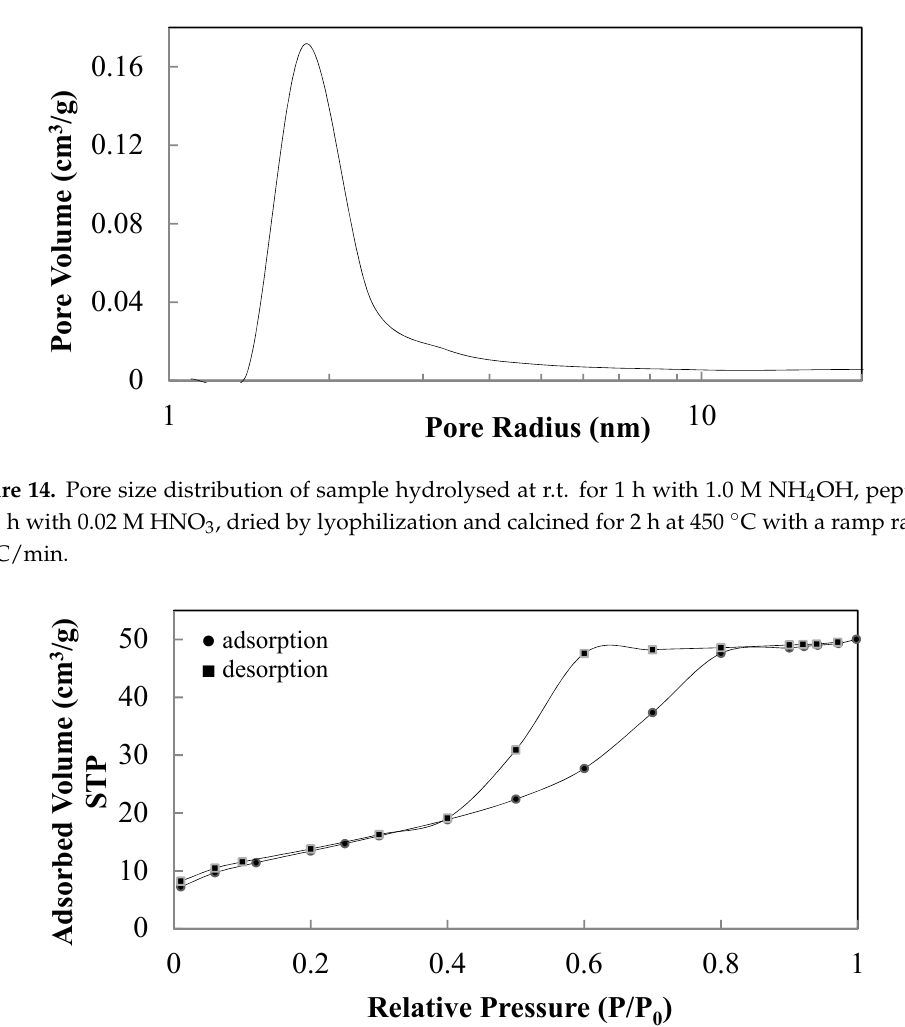
Figure 15. N 2 adsorption–desorption curves of sample hydrolysed at r.t. for 1 h with 1.0 M NH 4 OH, peptized for 1 h with 0.02 M HNO 3 , dried at 60 °C and calcined for 2 h at 450 °C with a ramp rate of 30 °C/min.